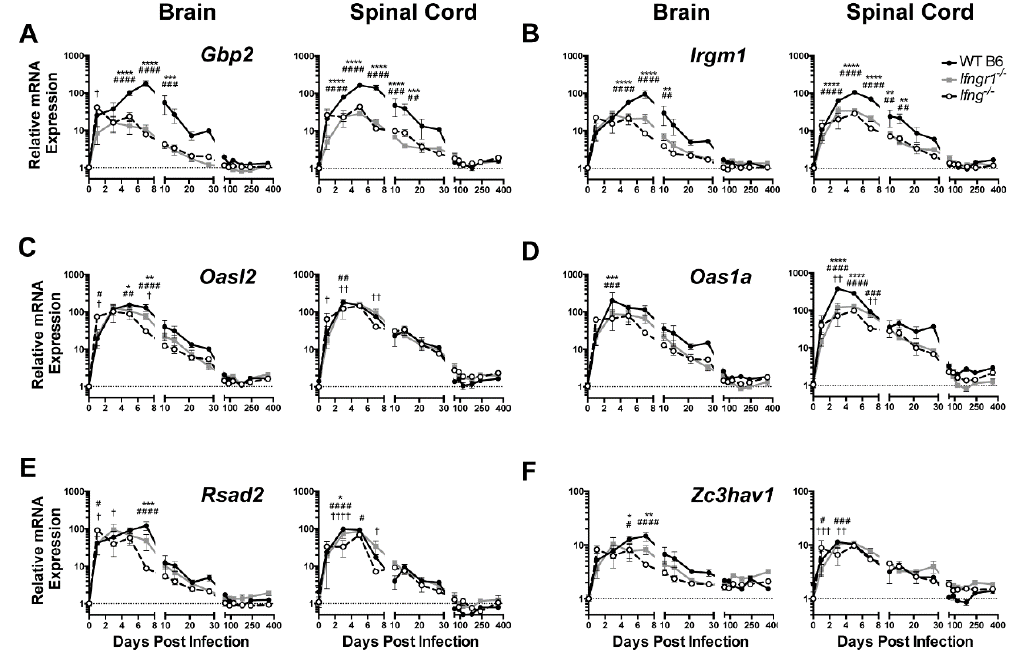
Figure 4. ISG expression in SINV-infected mice with impaired IFN- γ signaling. Expression of Gbp2 ( A ), Irgm1 ( B ), Oasl2 ( C ), Oas1a ( D ), Rsad2 ( E ), and Zc3hav1 ( F ) were examined by qRT-PCR in the brains ( left panels ) and spinal cords ( right panels ) of WT (black circle and solid line), Ifngr1 − / − (gray square and solid line), and Ifng − / − (white circle and black dashed line) mice ( n = 3–6 mice per strain per time point; data are presented as the mean ± SEM; dashed line indicates gene expression of 0 DPI tissue for each strain to which other time points were normalized; * p < 0.05, ** p < 0.01, *** p < 0.001, **** p < 0.0001, WT vs. Ifngr1 − / − ; # p < 0.05, ## p < 0.01, ### p < 0.001, #### p < 0.0001 WT vs. Ifng − / − ; † p < 0.05, †† p < 0.01, ††† p < 0.001, †††† p < 0.0001, and Ifngr1 −/− vs. Ifng −/− , all by Tukey’s multiple comparisons test).